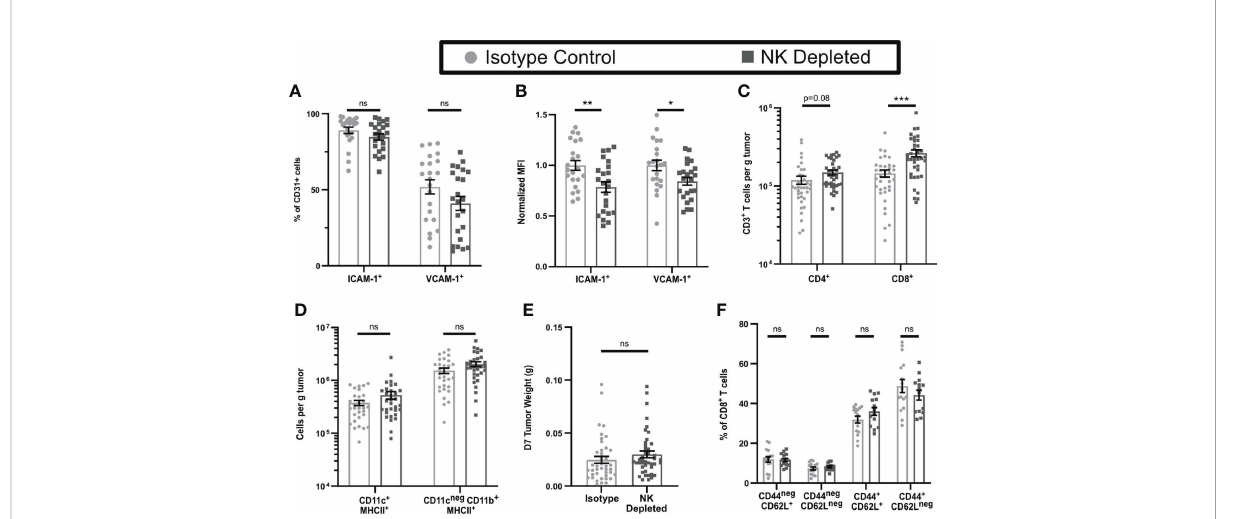
FIGURE 2 Early-stage tumors from mice lacking NK cells have reduced endothelial HRL expression but increased numbers of CD8 + T cells. B16-ova tumors were implanted into WT B6 mice treated with isotype control or anti-NK1.1 depleting antibodies on D-2, D1, and D4, and harvested on D7. Single cell suspensions were enriched for CD45 + cells using MACS Beads and the CD45 neg (A, B) or CD45 + (C – F) fractions were analyzed by fl ow cytometry. Data points represent a single tumor and mean per group with error bars representing SEM. Data are from: (A, B) 4 experiments; (C) 7 experiments; (D) 6 experiments; (E) 9 experiments; (F) 4 experiments. Statistics: Unpaired Student ’ s T test with Welch ’ s correction. *p < 0.05; **p < 0.01; ***p < 0.001; ns, not signi fi